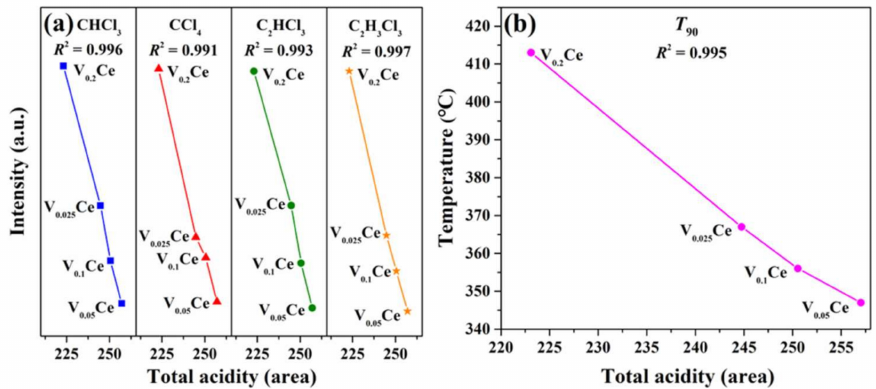
Figure 12. ( a ) Relationship between chlorinated byproduct yields and total acidity over VO x /CeO 2 catalysts; ( b ) relationship between T 90 of VO x /CeO 2 catalysts and total